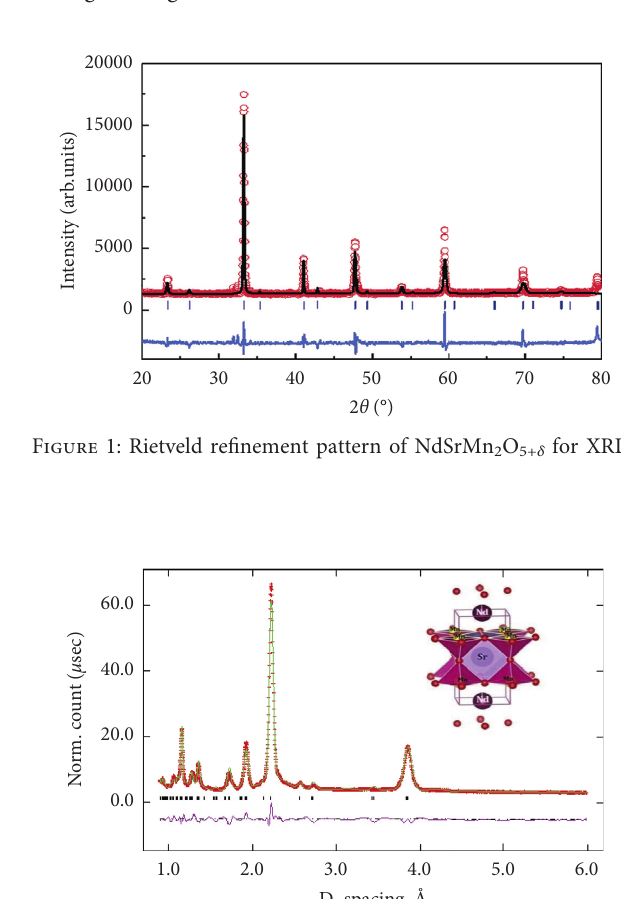
2 O 5+ δ at RT (space group, Pmmm ) with